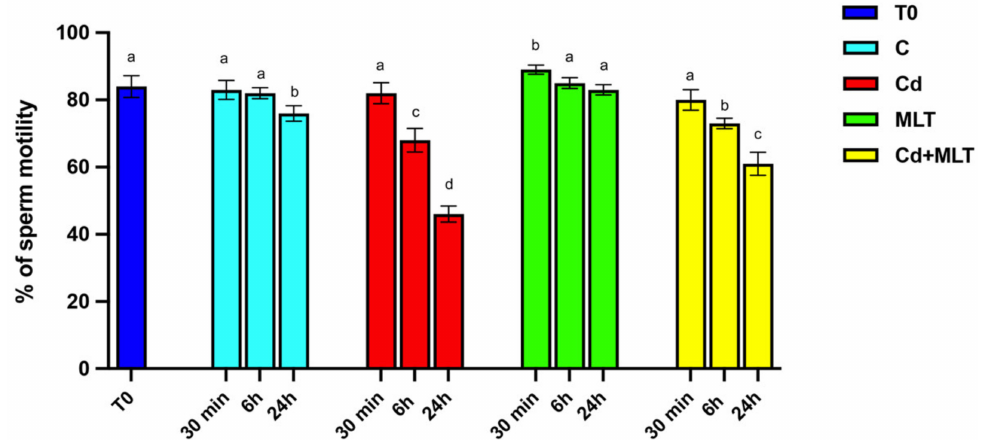
Figure 1. Sperm motility of samples incubated with cadmium (Cd) and/or melatonin (MLT) for 30 min, 6 h, and 24 h. Values are expressed as means ± SEM from 15 samples divided into the 5 groups, including the initial control (T0). a vs. b p < 0.05; a vs. c p < 0.01; a vs. d p < 0.001; b vs. c p < 0.05; b vs. d p < 0.01; c vs. d p <